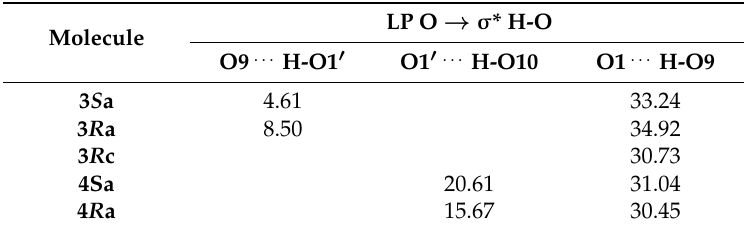
Table 11. Stabilization energies (kcal/mol) for selected NBO pairs (donor-acceptor) given by second-order perturbation energies for 3 and 4 .